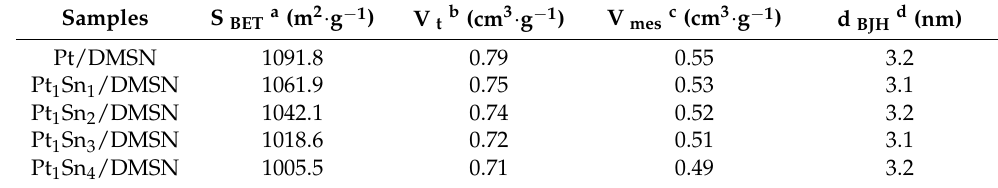
Table 1. Textural properties of the calcined PtSn/DMSN catalysts with different ratios of Pt/Sn. Samples